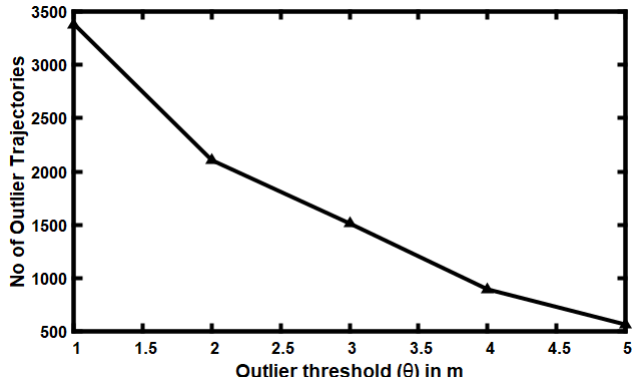
Figure 7. Effects of varying the outlier threshold ( θ ) on the number of discovered outliers’ trajectories.